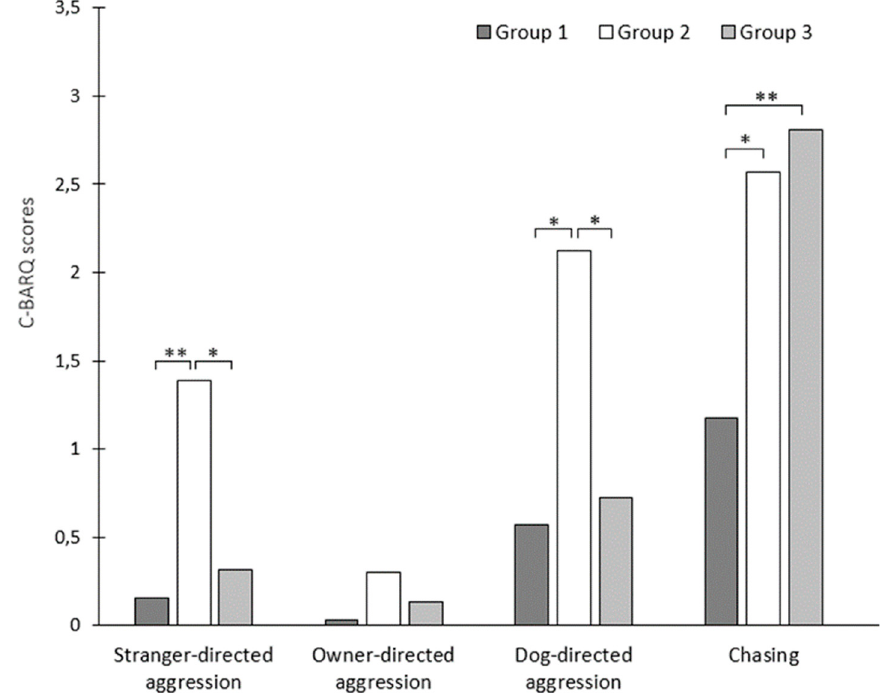
Figure 2. Owner-reported dog behavior using the C-BARQ questionnaire scoring by aggression groups (* p < 0.05; ** p < 0.001). Group 1 = non-aggressive dogs; Group 2 = dogs, aggressive towards humans; Group 3 = dogs, aggressive towards animals.